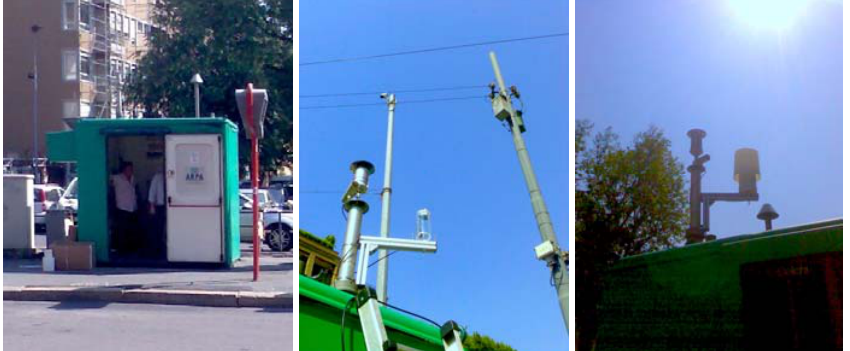
Figure 7. Outdoor experiment in downtown Milan. A station for air quality monitoring hosting standard GC instrumentation was selected as experimental site. Sensing unit was installed on the roof of the station, while the router PC collecting either the data from sensing unit, and the data from GC instruments, was installed in the inner